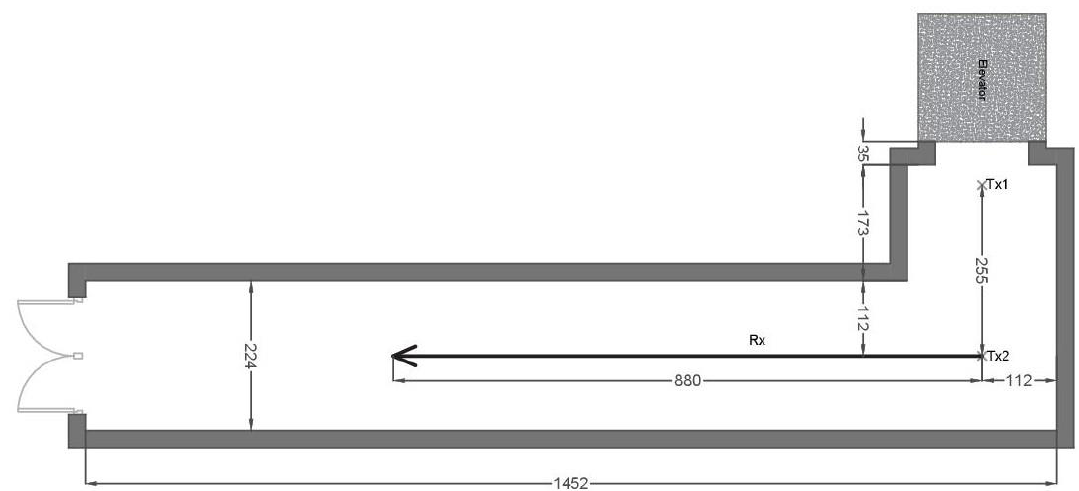
Figure 2. Floorplan of the corridor with dimensions in cm.